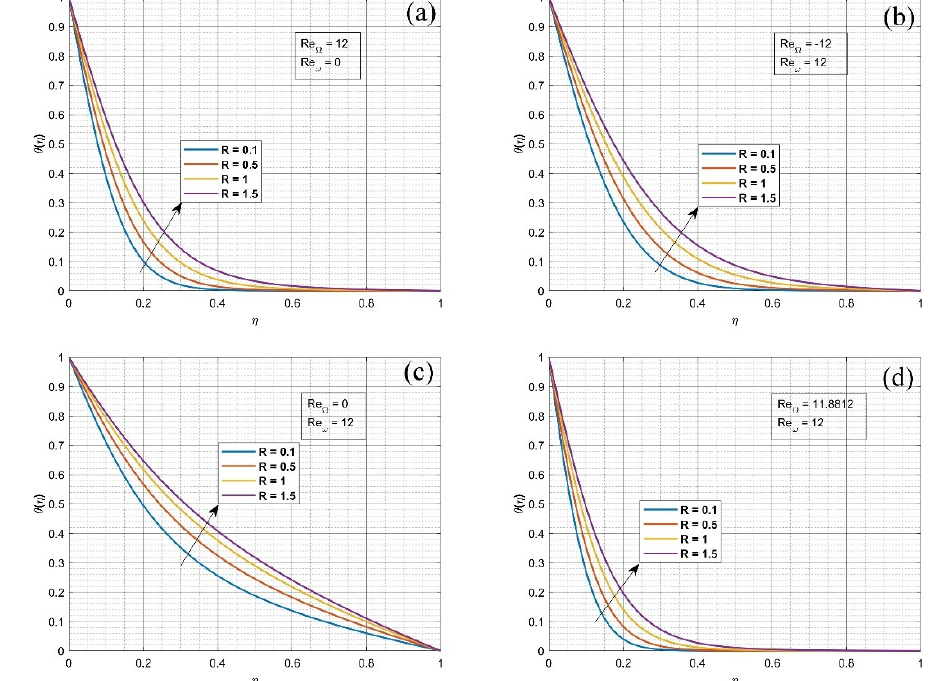
Figure 3. ( a – d ): Influence of radiation parameter on θ ( η ) for four different models; ( a ) the scenario between a rotating cone and stationary disk; ( b ) the scenario between a counter-rotating cone; ( c ) the scenario between a rotating disk and a stationary cone; ( d ) the scenario between a co-rotating cone and disk.